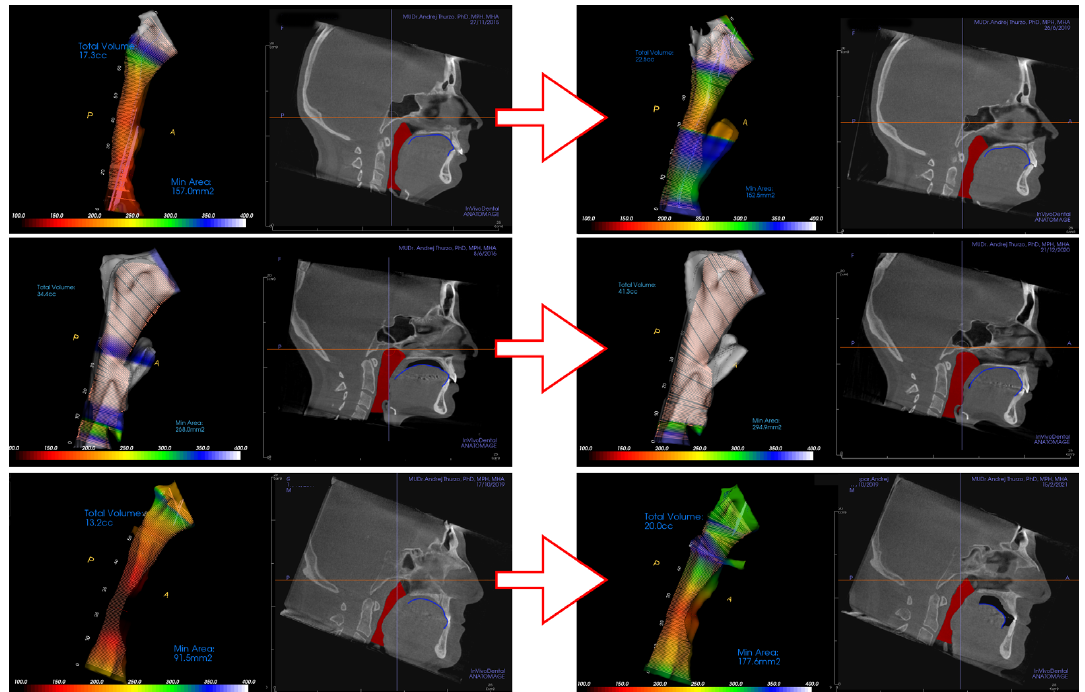
Figure 4. Various clinical situations in airway and tongue position in the oral cavity shown from the top. (1) Initially constricted airway ending in unconstricted setup with the tongue in connection with the upper palate and incisors with obvious change of lower incisors position. (2) In the middle is shown the situation of patient from control group with permanently unconstricted airway with changed tongue position. (3) Example on the bottom shows improvement in the airway clearance despite tongue position in the oral cavity being posterior in comparison to initial CBCT.